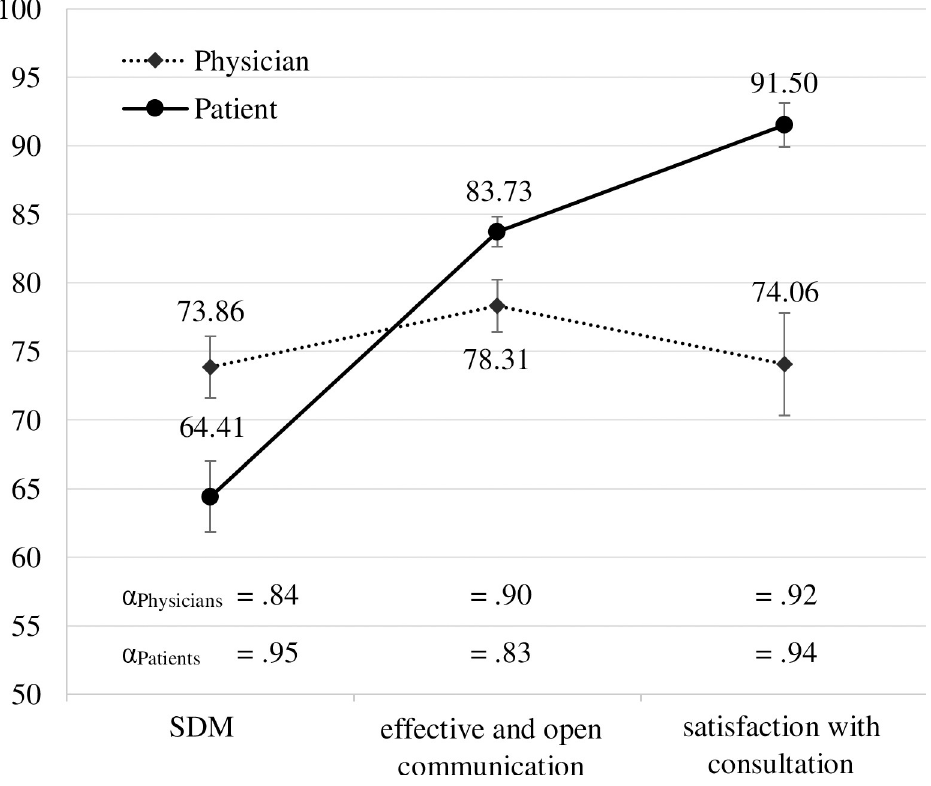
Fig 1. Mean scores, standard errors and Cronbach’s α for physician and patient rating